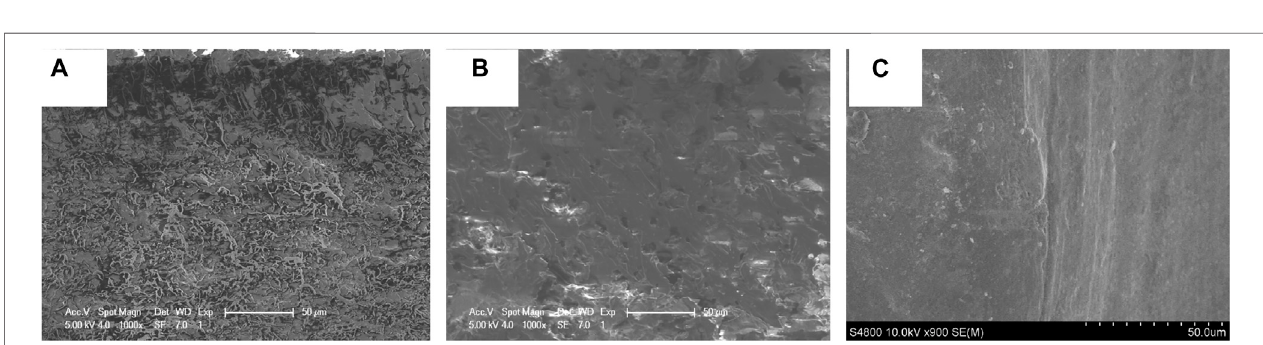
Frontiers in Materials |